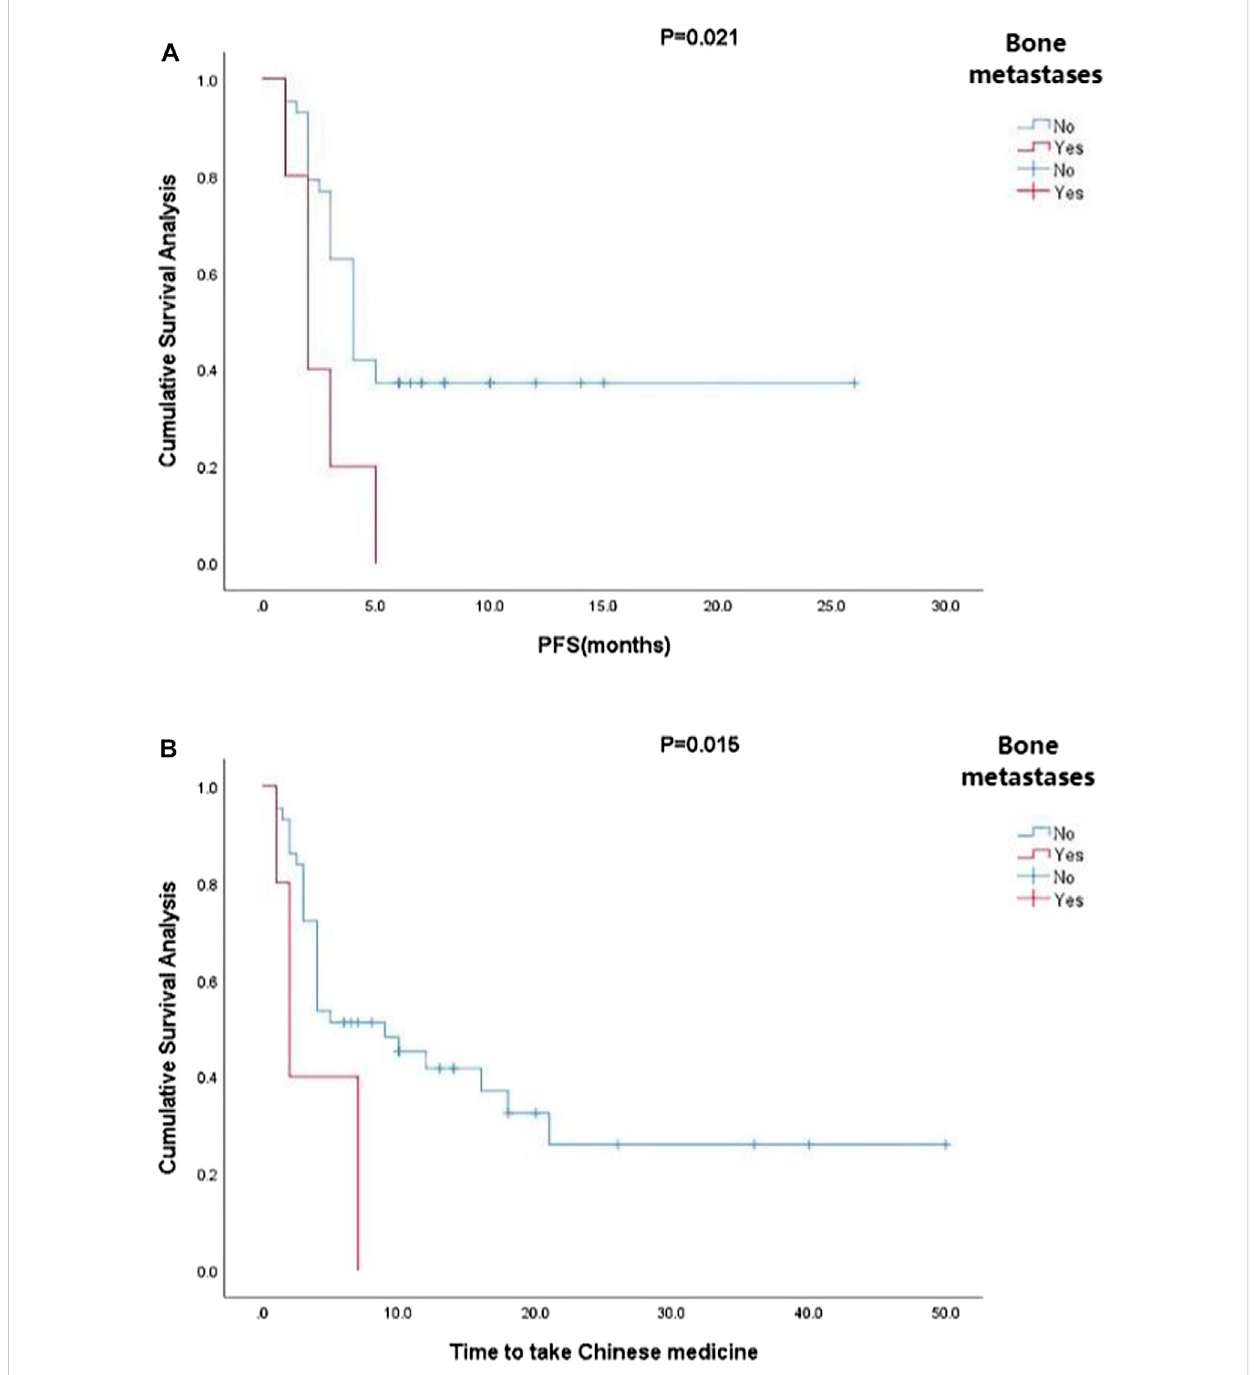
Kaplan-Meier plots showing (A) PFS and (B) TTCM in patients with advancedcolorectal cancer and bone metastases. PFS, progression-free survival; TTCM, total duration of traditional Chinese